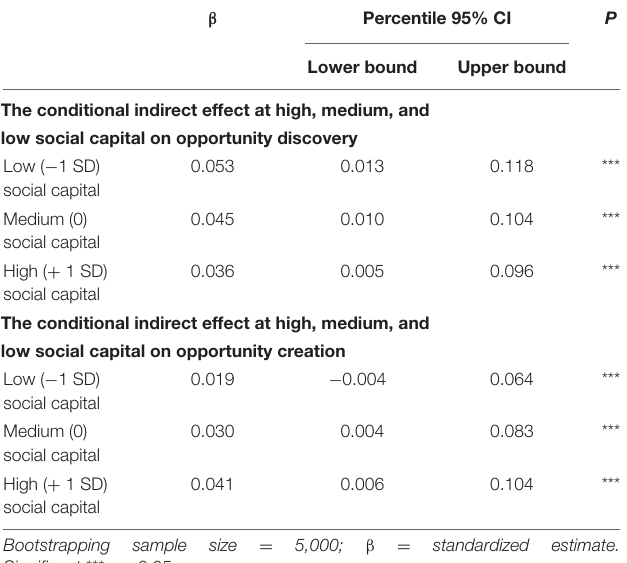
TABLE 6 | Conditional indirect effects.